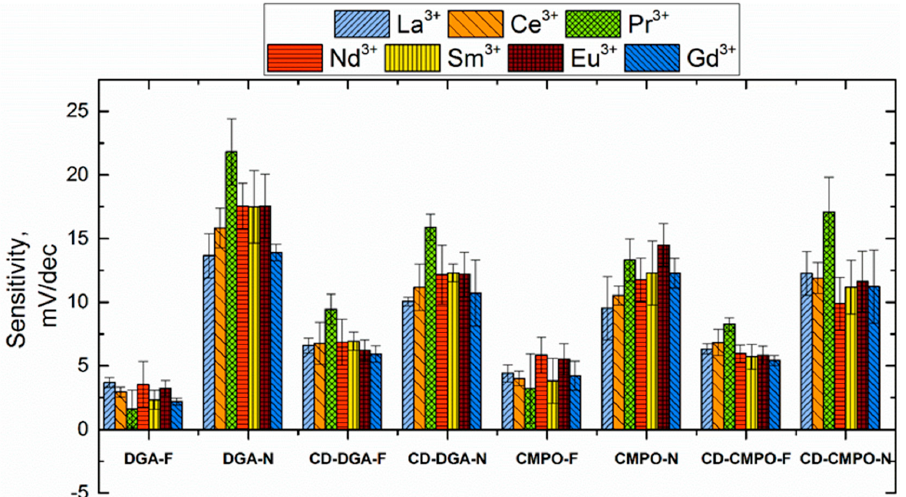
Figure 4. Sensitivity values measured in REE solutions for sensors with ligands covalently bonded to the CD and for sensors with equimolar mixtures of the ligand and CCD.